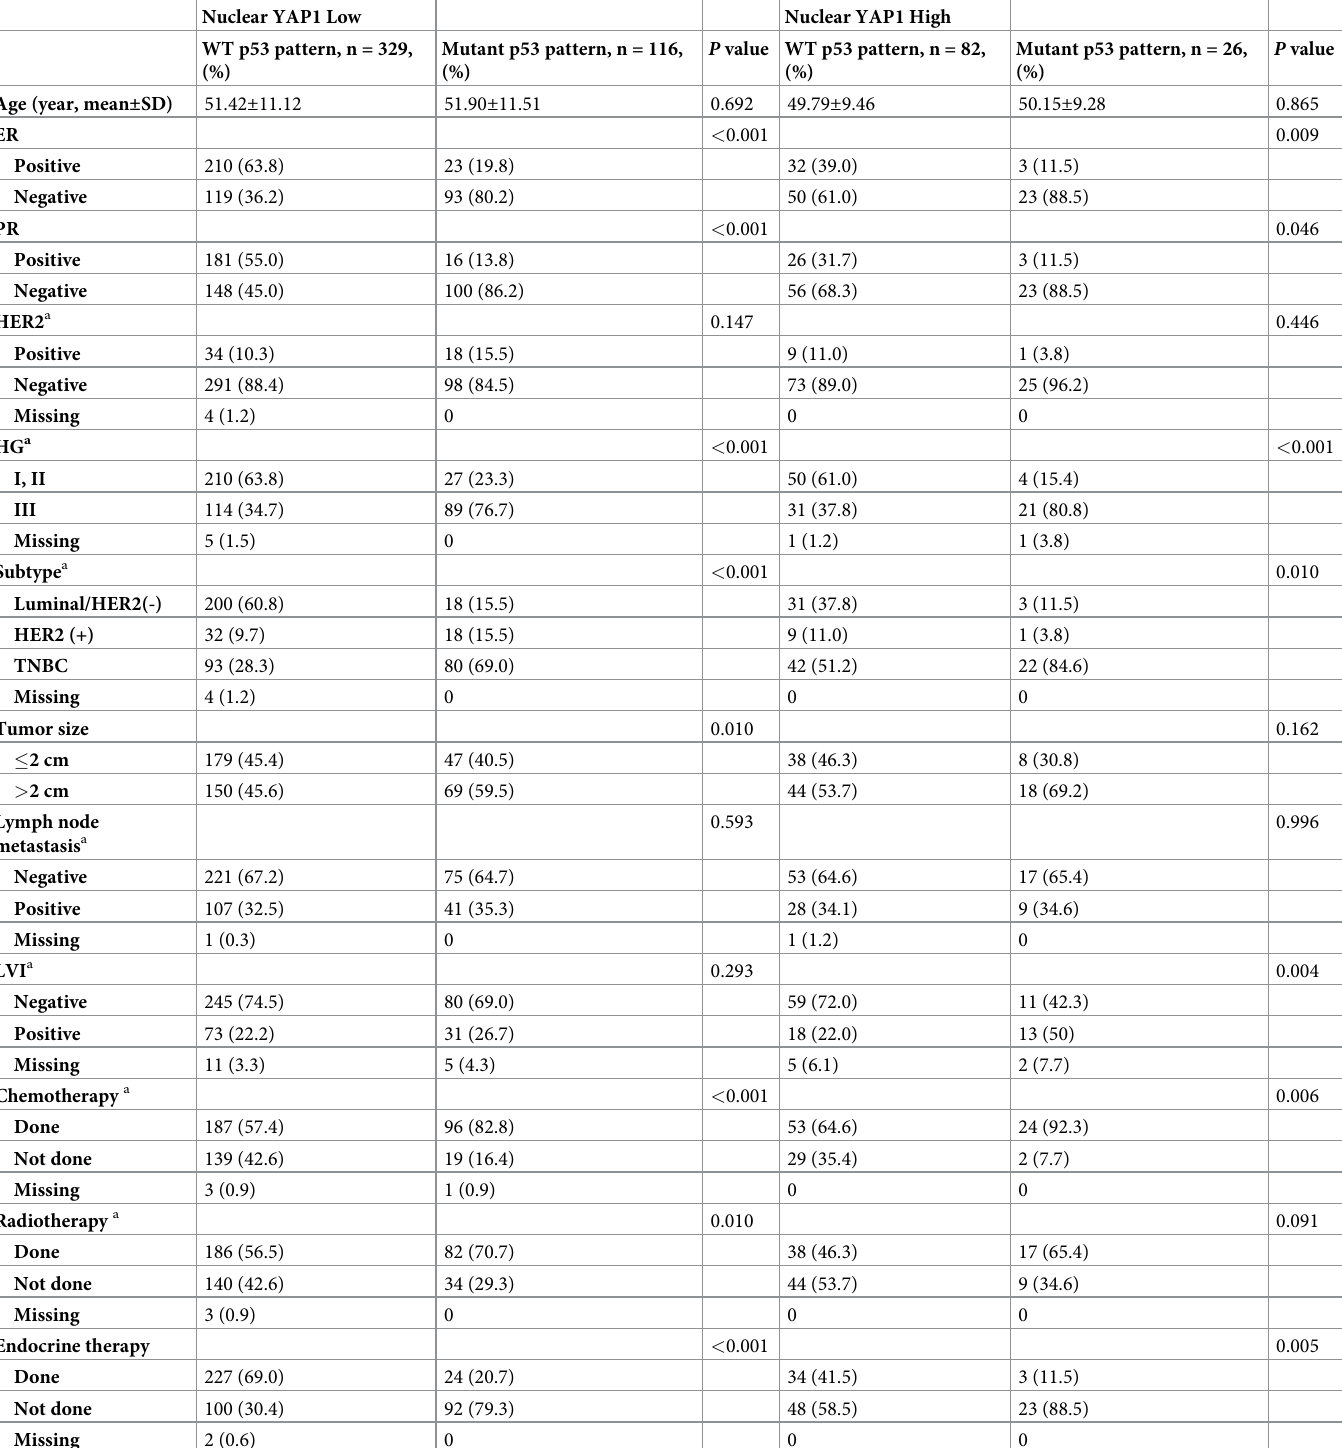
Table 1. Clinical characteristics in relation to nuclear YAP1 expression and p53 expression